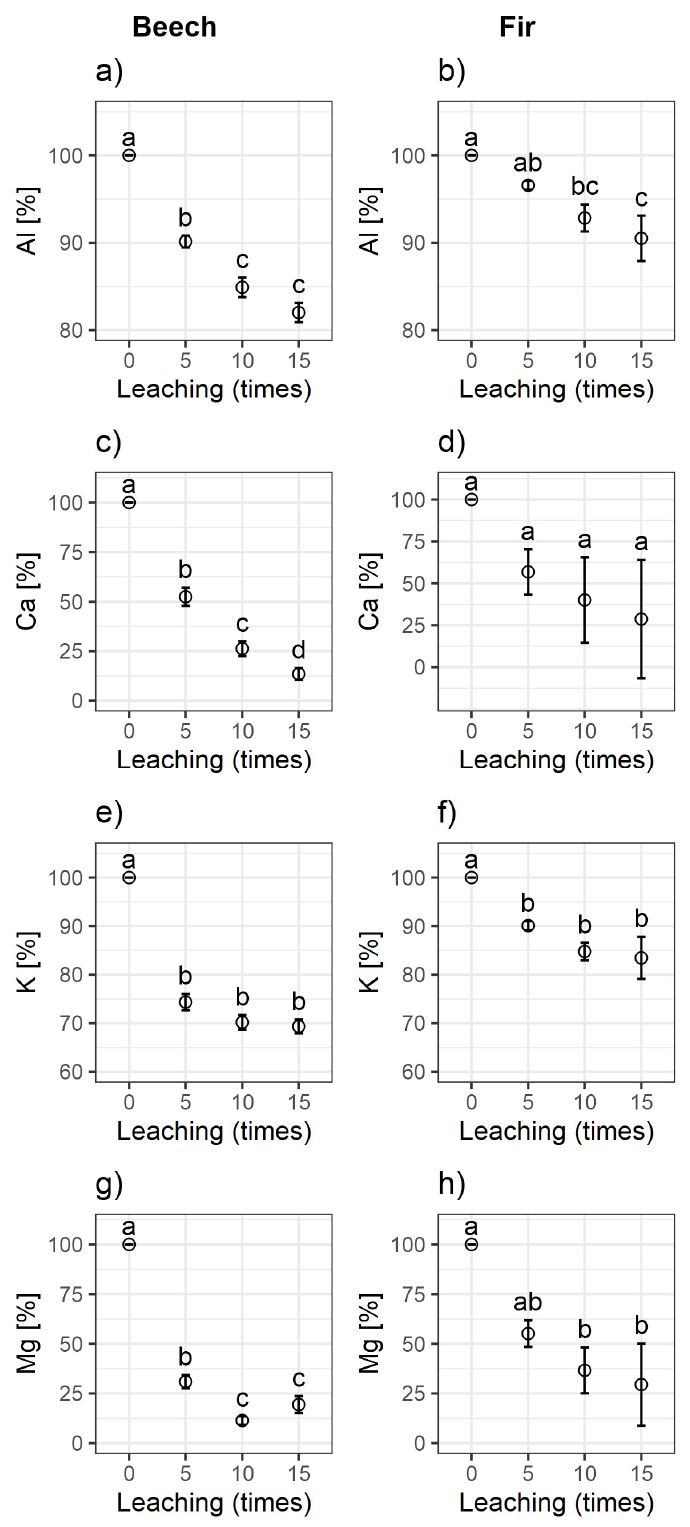
Figure 1. Comparison of percentage changes in the contents of soil cations ( a ) Al 3+ , ( c ) Ca 2+ , ( e ) K + , and ( g ) Mg 2+ in soils under beech and ( b ) Al 3+ , ( d ) Ca 2+ , ( f ) K + and ( h ) Mg 2+ in soils under fir stands as a result of leaching (0 (non-leached), 5, 10, and 15 times).